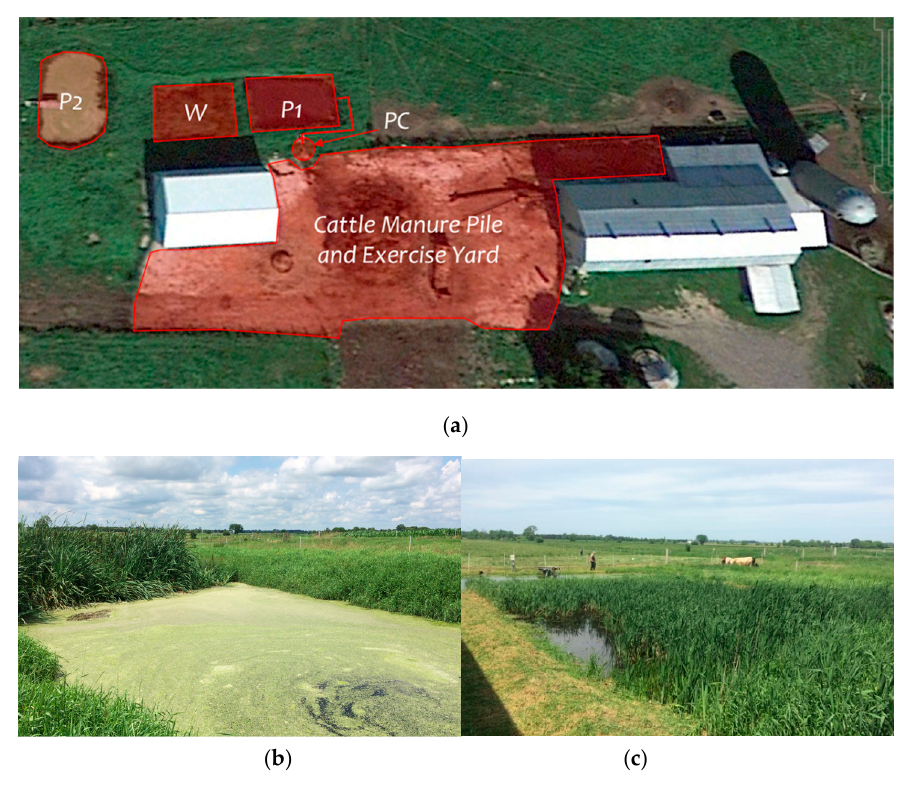
Figure 1. ( a ) Plan view of the exercise yard and treatment system (pump chamber, PC; primary treatment pond, P1; free-water surface constructed wetland, W; and settling pond, P2) at the Pemdale farm, Winchester, ON. Google Earth V 7.3.1.4507 imagery (2 September 2016, eye alt 137 m); ( b ) Picture of the P1 in June; ( c ) Picture of W in